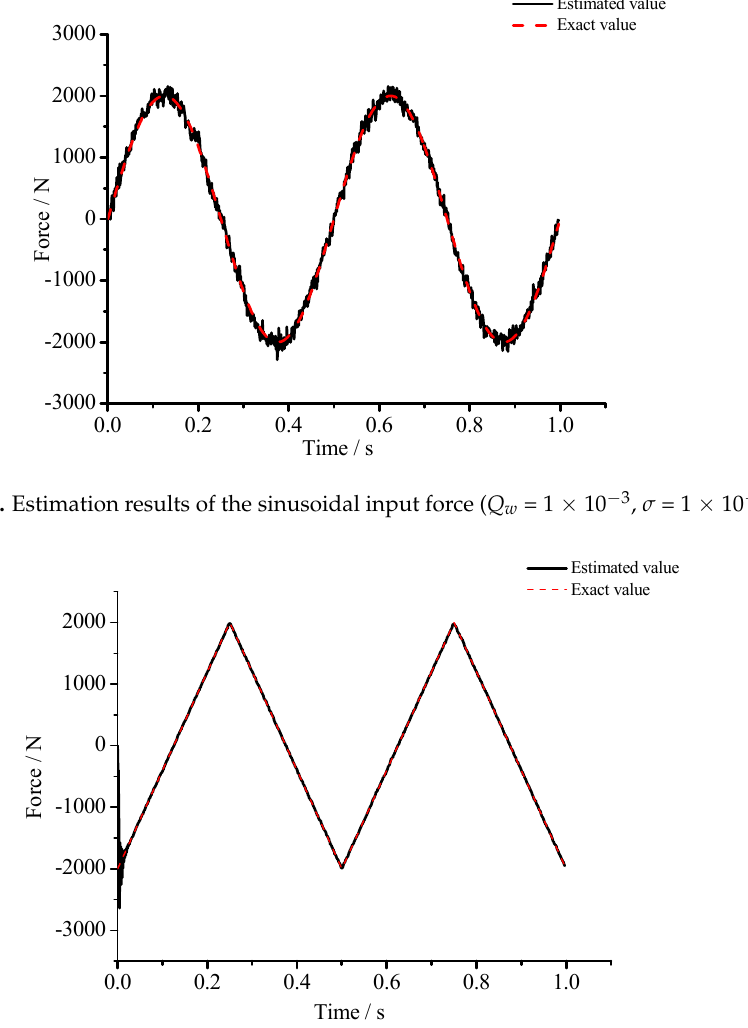
Figure 5. Estimation results of the triangular input force ( Q w = 1 × 10 − 4 , σ = 1 × 10 − 8 ) .